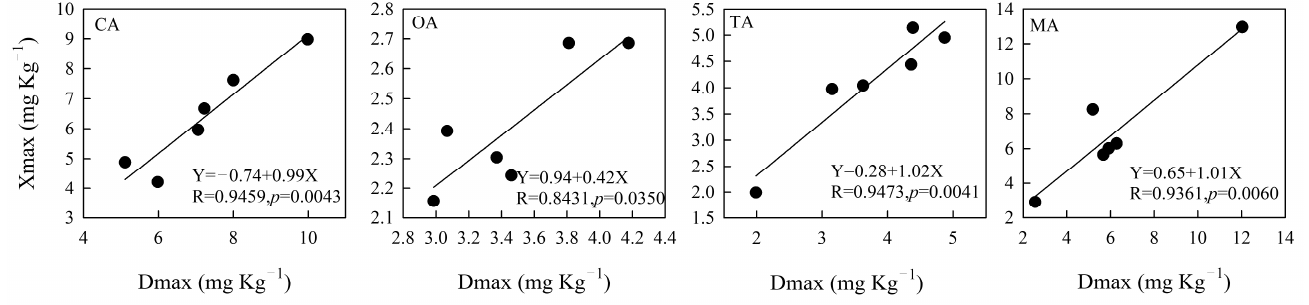
According to Figure 6, X max , calculated by the quadratic polynomial equation (Table 4), had a significant linear correlation with the measured value of the maximum amount of P extracted by organic acid ( D max ) ( p < 0.05). The fitting effect of citric, tartaric, and malic acids was better than that of oxalic acid based on the linear equation in the six sampling areas. The correlation coefficients of citric, tartaric, and malic acids were higher than 0.93